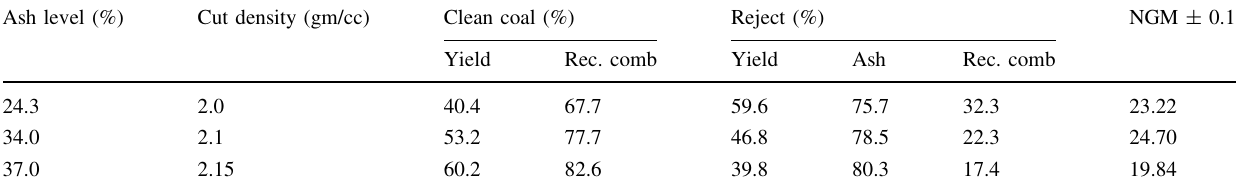
Table 4 Washability results at different ash levels Ash level